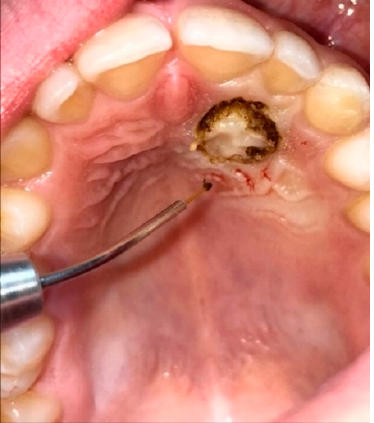
Figure 3. Laser surgery.